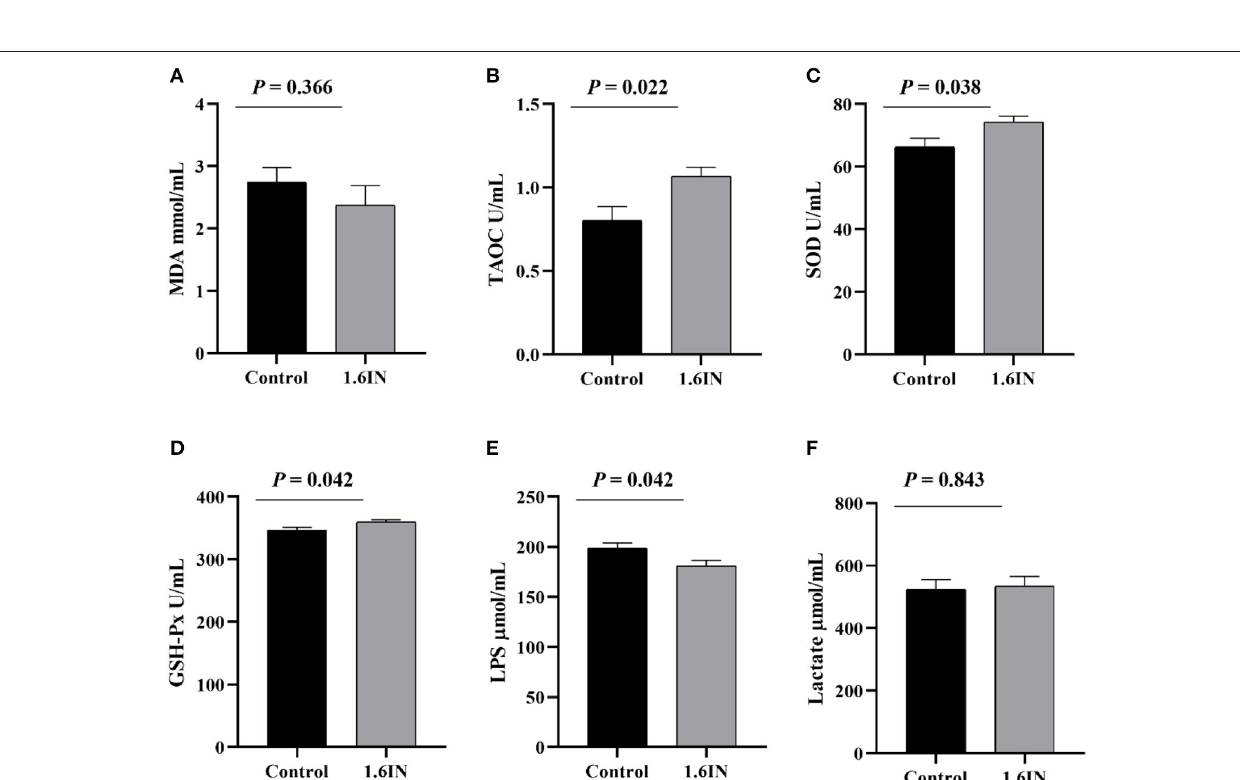
FIGURE 5 | Effects of dietary inulin on the serum markers of sows (A) malondialdehyde, MDA; (B) total antioxidant capacity, TAOC; (C) superoxide dismutase, SOD; (D) glutathione peroxidase, GSH-Px; (E) lipopolysaccharide, LPS; (F) lactate. Significance was analyzed by an unpaired t -test.